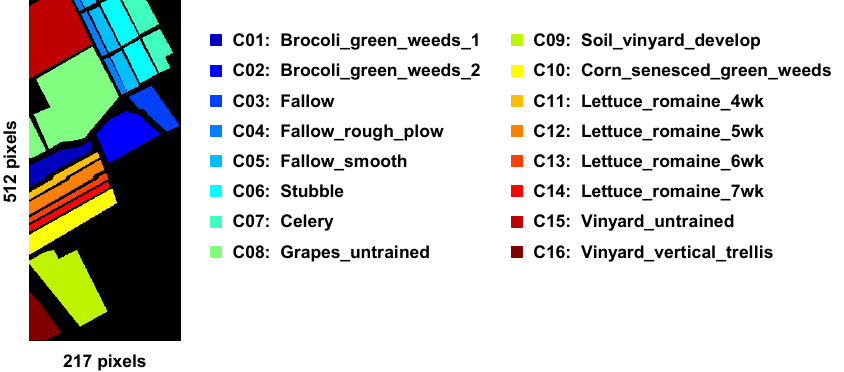
Figure 3. Reference labels for the Salinas dataset: each pixel is characterized by reflectance values on 204 spectral bands. Unlabeled pixels are indicated in